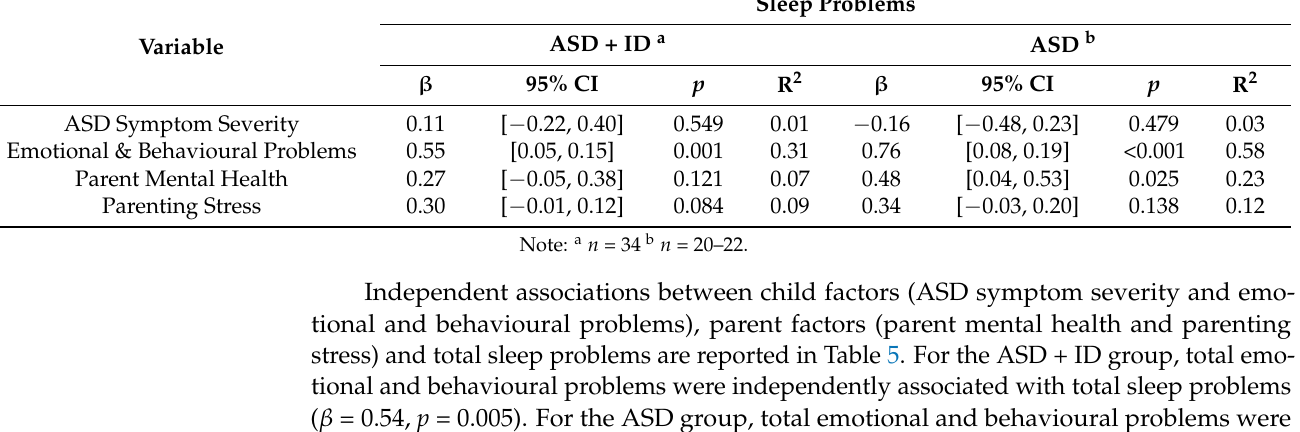
Table 5. Independent Associations between Child Factors, Parent Factors and Child Sleep Problems.